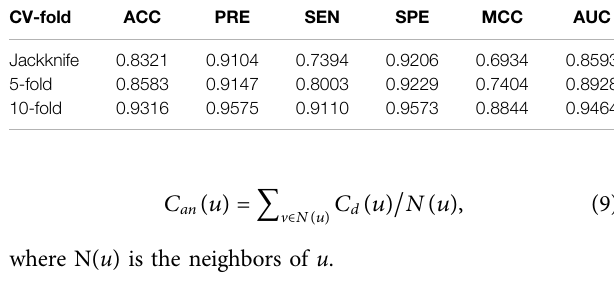
TABLE1| PerformancecomparisonofdifferentfeaturecombinationsinXGBoost. Feature group